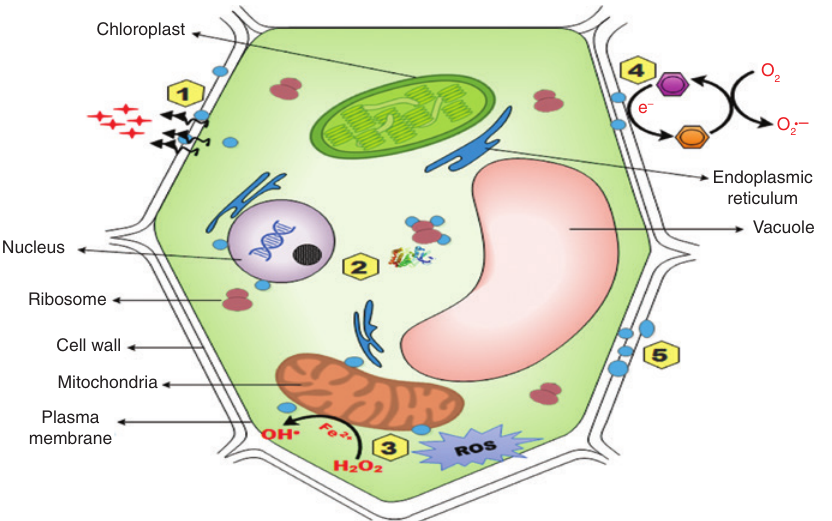
Figure 6: Schematic representation of several proposed mechanisms by which CuNPs cause phytotoxicity: (1) dissolution of nanoparticles and release of toxic ions, (2) binding and interaction of nanoparticles with biomolecules, such as proteins and DNA, (3) production of ROS through redox cycling and Fenton reaction, (4) oxidation and surface catalytic reactions, and (5) size-or- shape-dependent mechanical